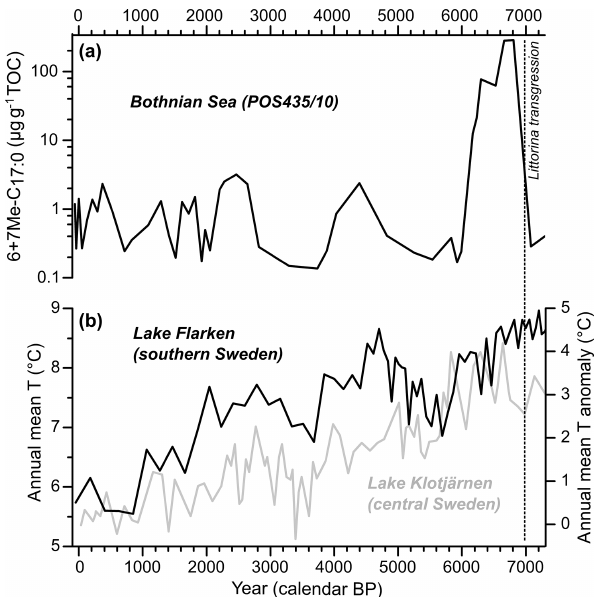
Figure 6. Holocene (0–7000cal.yrBP) records of the TOC normal- ized sum of 6Me-C 17 : 0 and 7Me-C 17 : 0 (6 + 7Me-C 17 : 0 ; log scale) in the Bothnian Sea (core POS435/10; Häusler et al., 2017) (a) and of two pollen-based annual mean temperature reconstructions from Swedish lakes (Seppä et al., 2009) (b) . The Littorina transgression marking the limit between the Ancylus Lake stage and the Littorina Sea stage is shown as a dashed line. The data are listed in Table